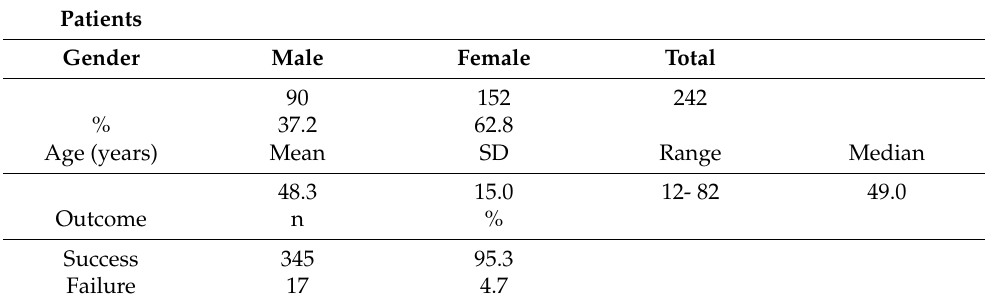
Table 1. Number of understudied patients and their endoscopic endodontic surgery success rates.